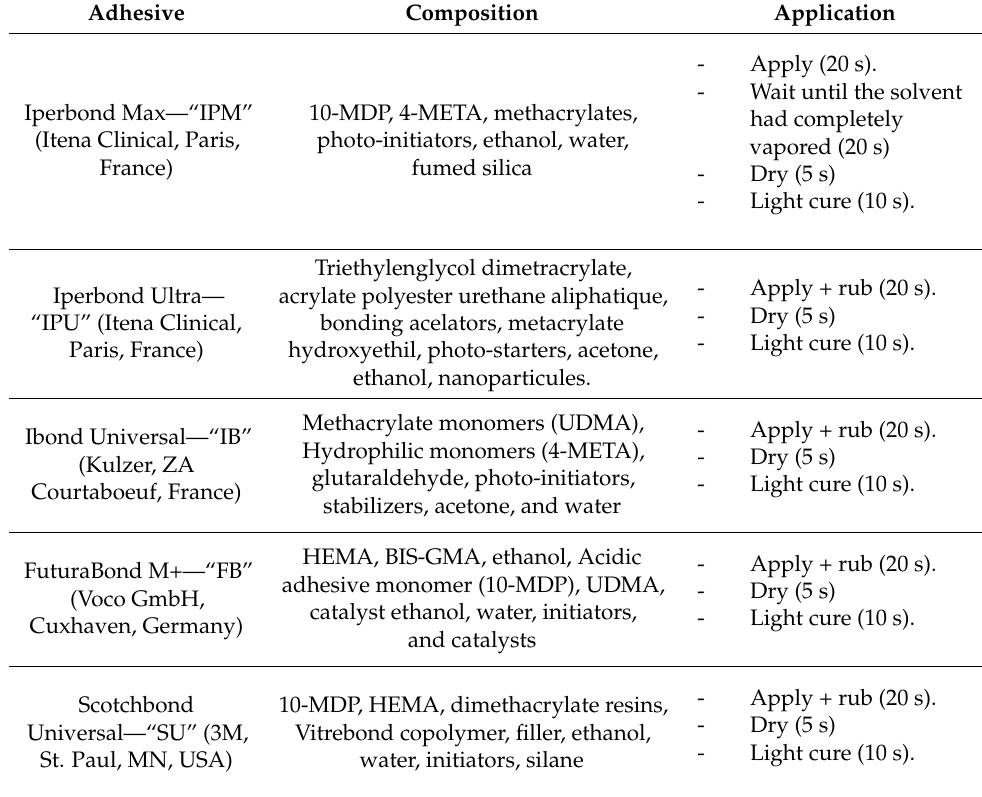
Table 1. Adhesive system: chemical composition, application process, and manufacturing